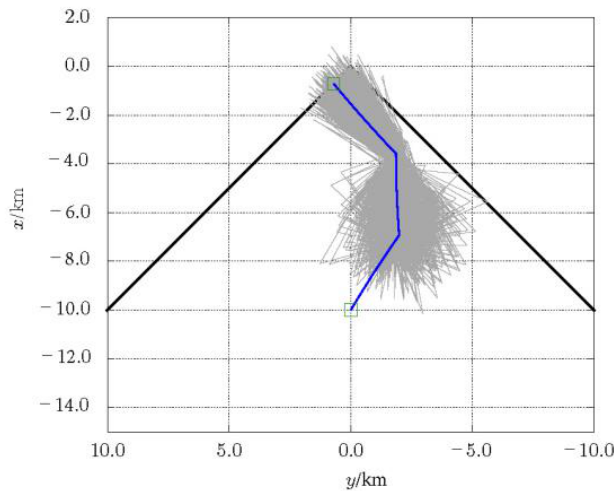
Figure 13. Deterministic guidance with the SaG strategy case: the Monte Carlo sample trajectories have a large spatial deviation from the nominal trajectory. Table 5. The characteristic of the nominal trajectory for π det erm .